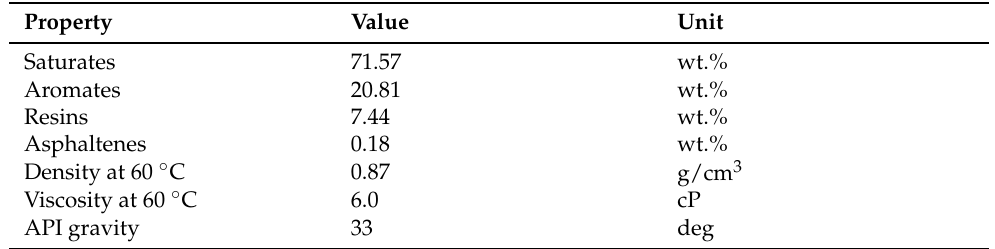
Table 3. Properties of the crude oil.